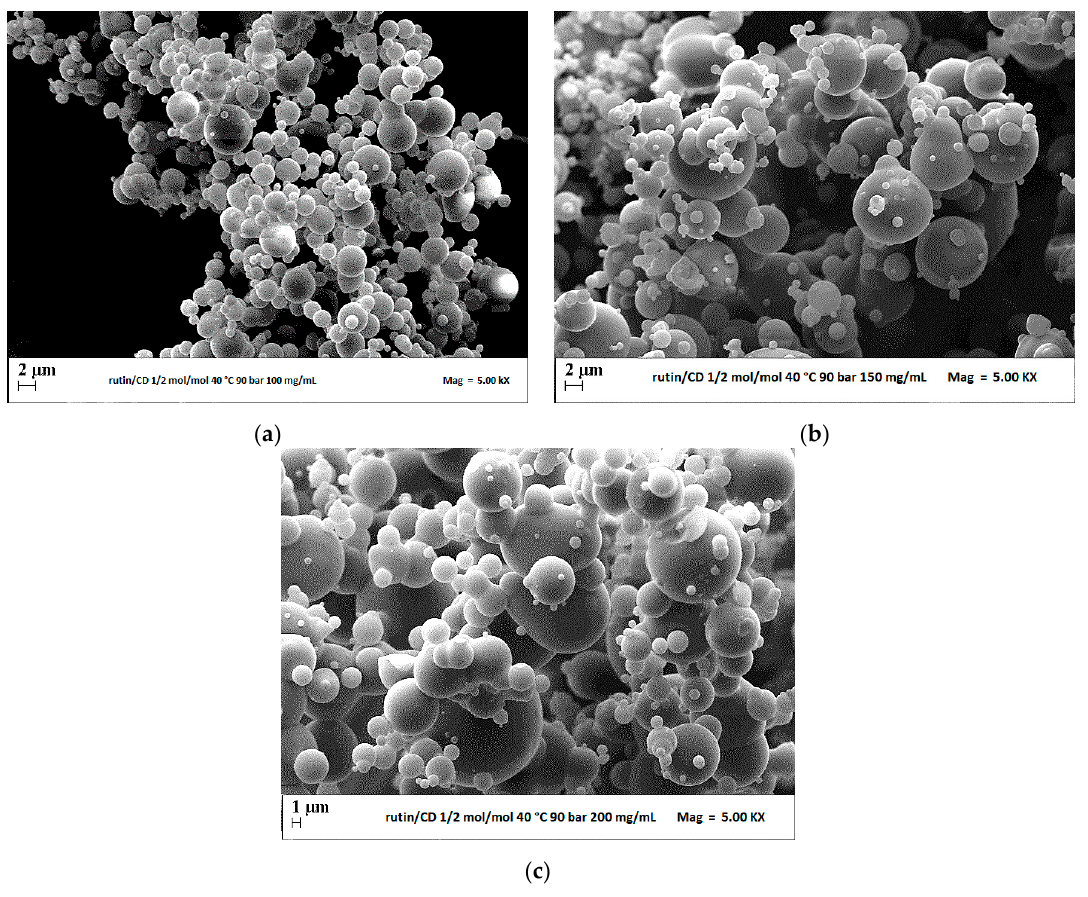
Figure 3. FESEM images of microparticles RUT– β‐ CD 1:2 mol:mol precipitated from DMSO at 40 °C, 9 MPa and ( a ) 100 mg/mL (run #3); ( b ) 150 mg/mL (run #4); ( c ) 200 mg/mL (run #5).